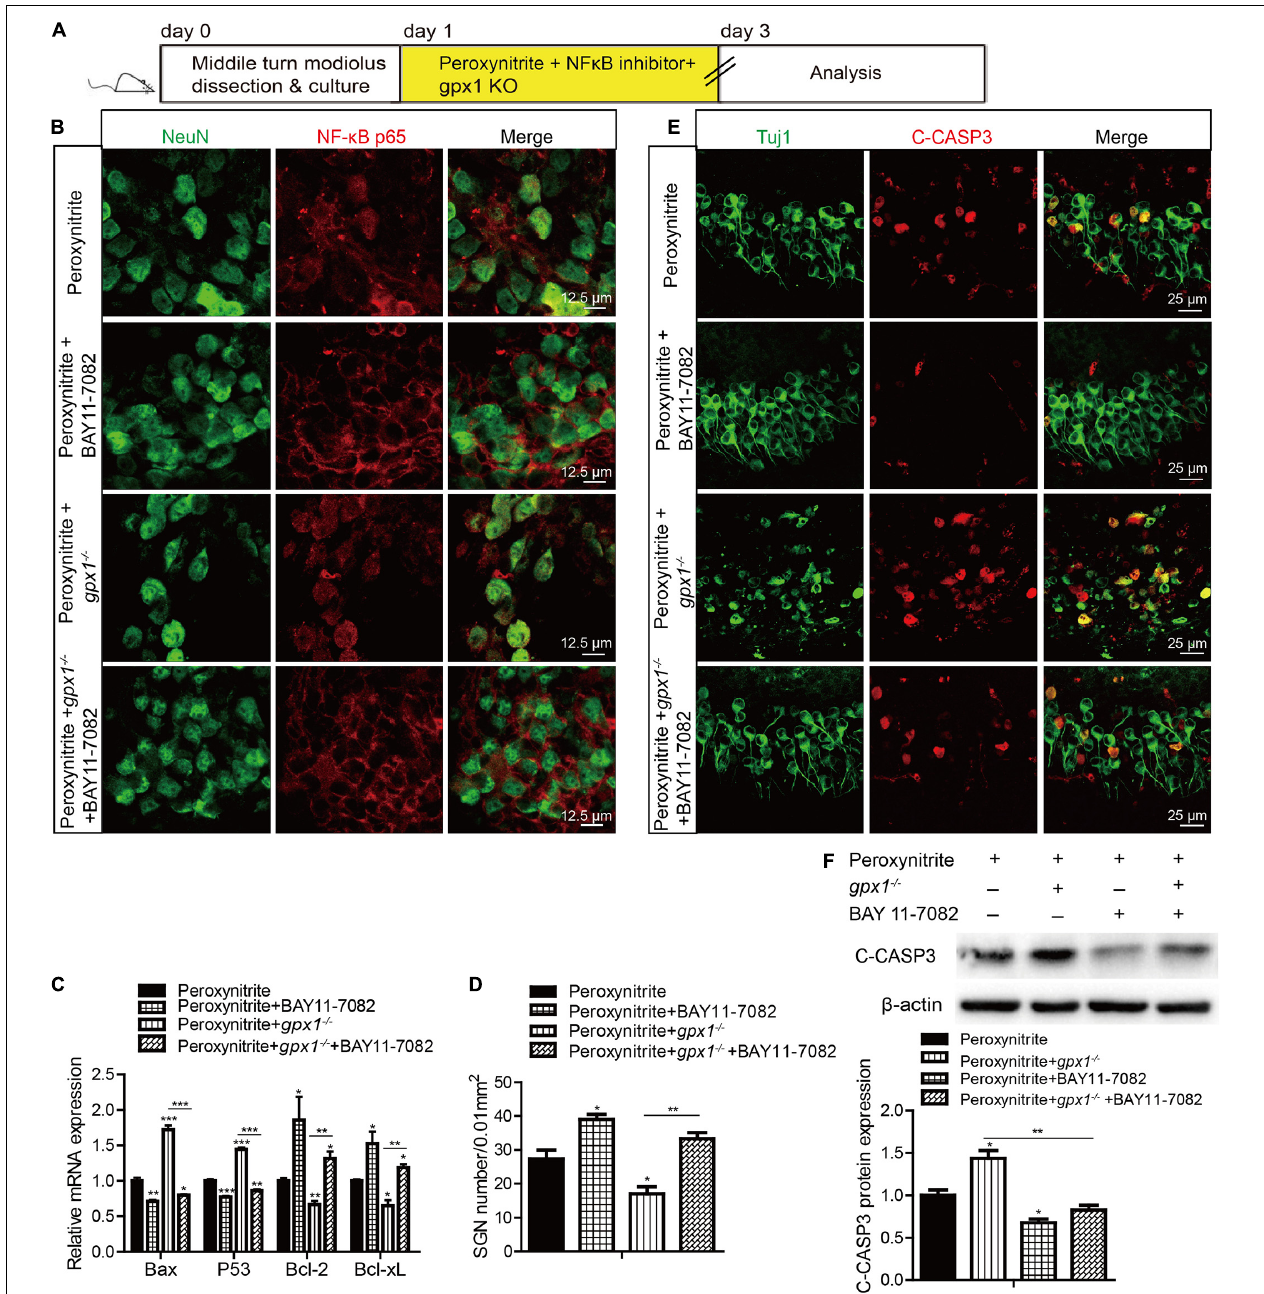
FIGURE 9 | Glutathione peroxidase inhibits the NF- κ B pathway to protect against peroxynitrite-induced SGNs damage. (A) The cultured SGN explants from WT or gpx1 − / − mice were treated with peroxynitrite and 10 µ M BAY 11-7082 for 48 h. (B,C) Immunostaining and RT-PCR results showed that BAY 11-7082 effectively inhibited the nuclear translocation of NF- κ B p65 and the mRNA expression of Bax and P53 , but increased the mRNA expression of Bcl2 and Bcl-xL , in the peroxynitrite + BAY 11-7082 group compared with the peroxynitrite-only group, as well as in the peroxynitrite + gpx1 − / − + BAY 11-7082 group compared with the peroxynitrite + gpx1 − / − group. Scale bar = 12.5 µ m. (D–F) Immunostaining, cell counting, and western blot results showed that the inhibition of NF- κ B by BAY 11-7082 significantly increased the survived SGN numbers, while decreased the C-CASP3 positive SGNs numbers and the C-CASP3 expression in the peroxynitrite + BAY 11-7082 group compared with the peroxynitrite group. Moreover, BAY 11-7082 treatment also increased the number of SGNs, whereas reduced the C-CASP3 expression in the peroxynitrite + gpx1 − / − + BAY 11-7082 group vs. the peroxynitrite + gpx1 − / − group. Scale bar = 25 µ m. * p < 0.05, ** p < 0.01, and *** p < 0.001, n = 3 for each